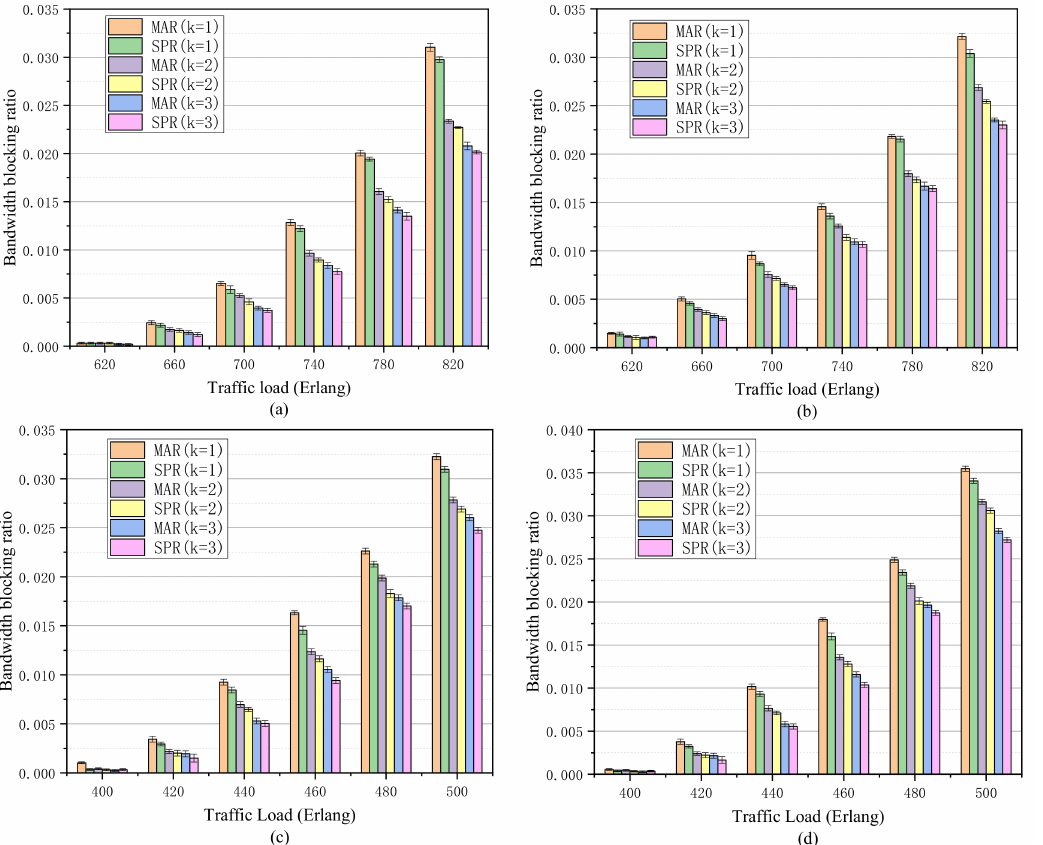
Figure 5. Simulation and results. ( a ) BBR under uniform traffic model when 16 nodes are upgraded in USNET; ( b ) BBR under non-uniform traffic model when 16 nodes are upgraded in USNET; ( c ) BBR under uniform traffic model when 10 nodes are upgraded in NSFNET; ( d ) BBR under non-uniform traffic model when 10 nodes are upgraded in